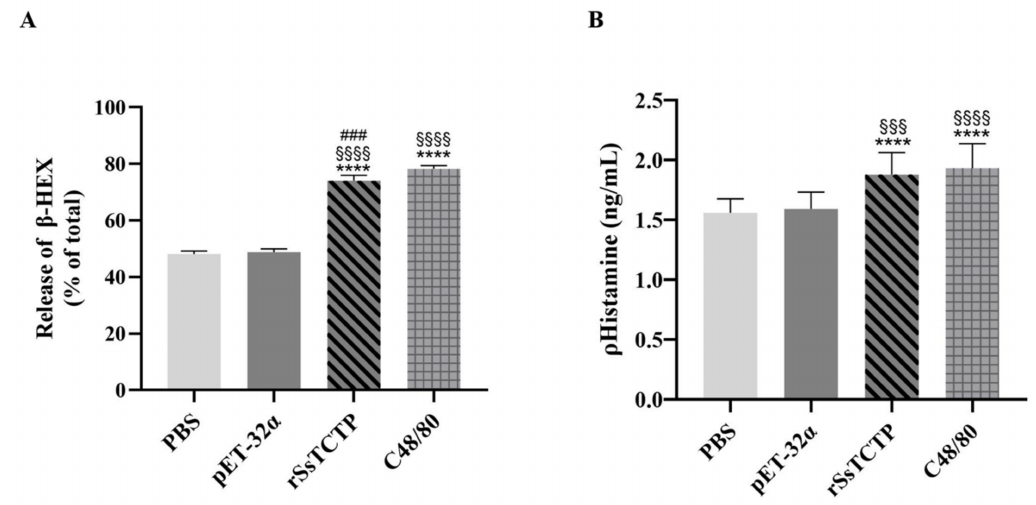
Figure 6. Release of β -Hexosaminidase ( β -HEX) ( A ) and histamine ( B ) from KU812 cells. Data from three individual experiments (each experiment had five replicates) are shown as the means ± the standard deviation (SD). **** p < 0.0001 versus PBS group; §§§ p < 0.001, §§§§ p < 0.0001 versus pET-32 α group; ### p < 0.001 versus C48/80 group ( t -test). rSsTCTP, recombinant Sarcoptes scabiei translationally controlled tumor protein.